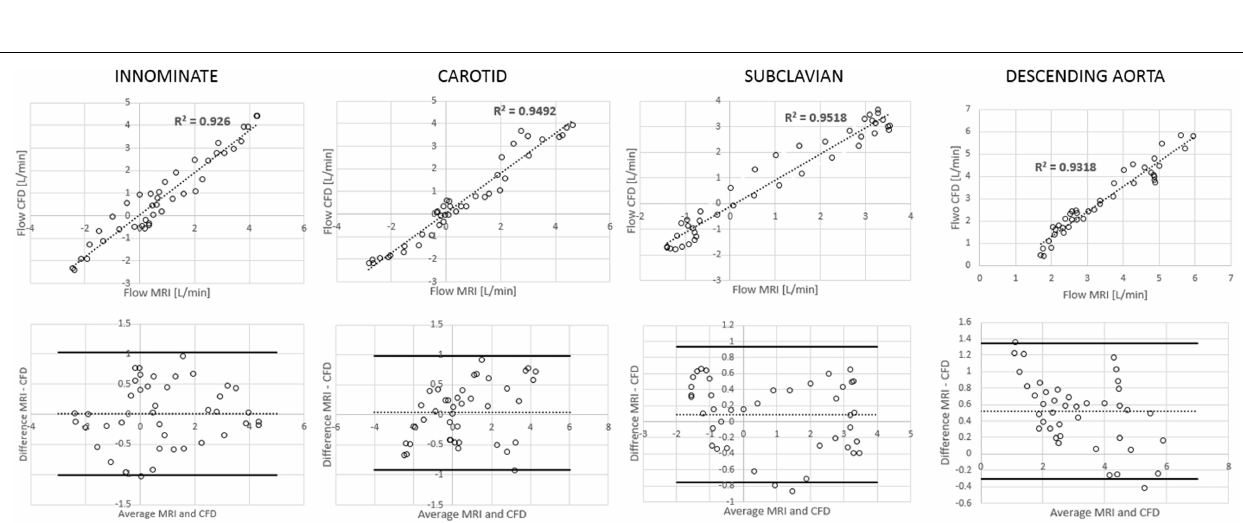
While CMR can be prone to limitations in terms of spatial and temporal resolution, hence the duration of the acquisition, CFD results are affected by assumptions (e.g., flow regime) and boundary conditions. With regards to the latter and setting up the